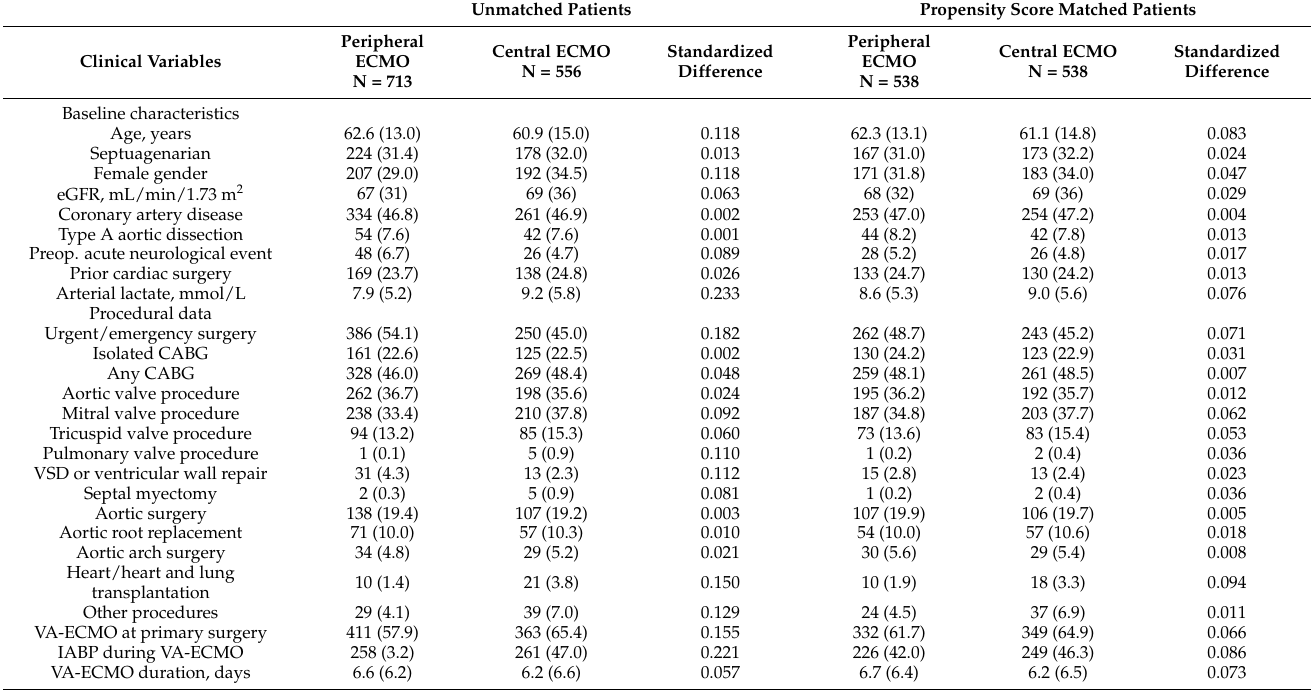
Table 4. Patients’ characteristics and operative data in unmatched and propensity score matched